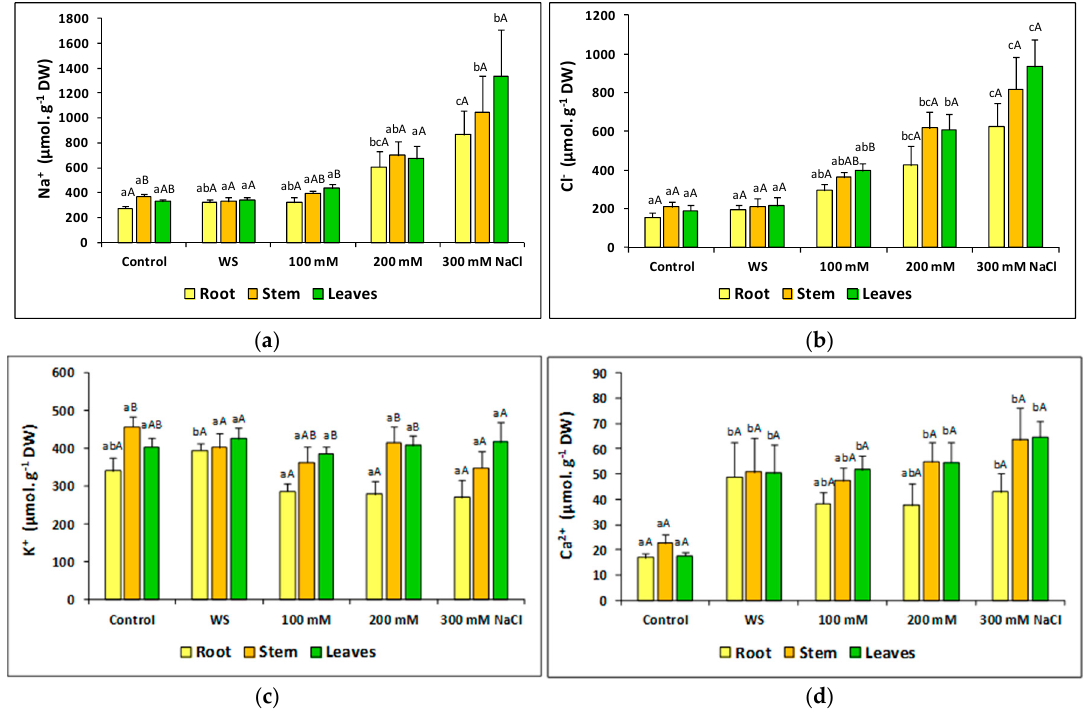
Figure 7. Ion contents, Na + ( a ), Cl - ( b ), K + ( c ), Ca 2 + ( d ), after 23 days of stress treatments, in roots, stems and leaves of Thalictrum maritimum plants grown in controlled conditions in the greenhouse. Values shown are means ± SE ( n = 5). For each organ, same lowercase letters over the bars indicate homogeneous groups between treatments, whereas for each treatment same uppercase letters indicate homogeneous groups between roots, stems and leaves, according to the Tukey test ( p ≤ 0.05).